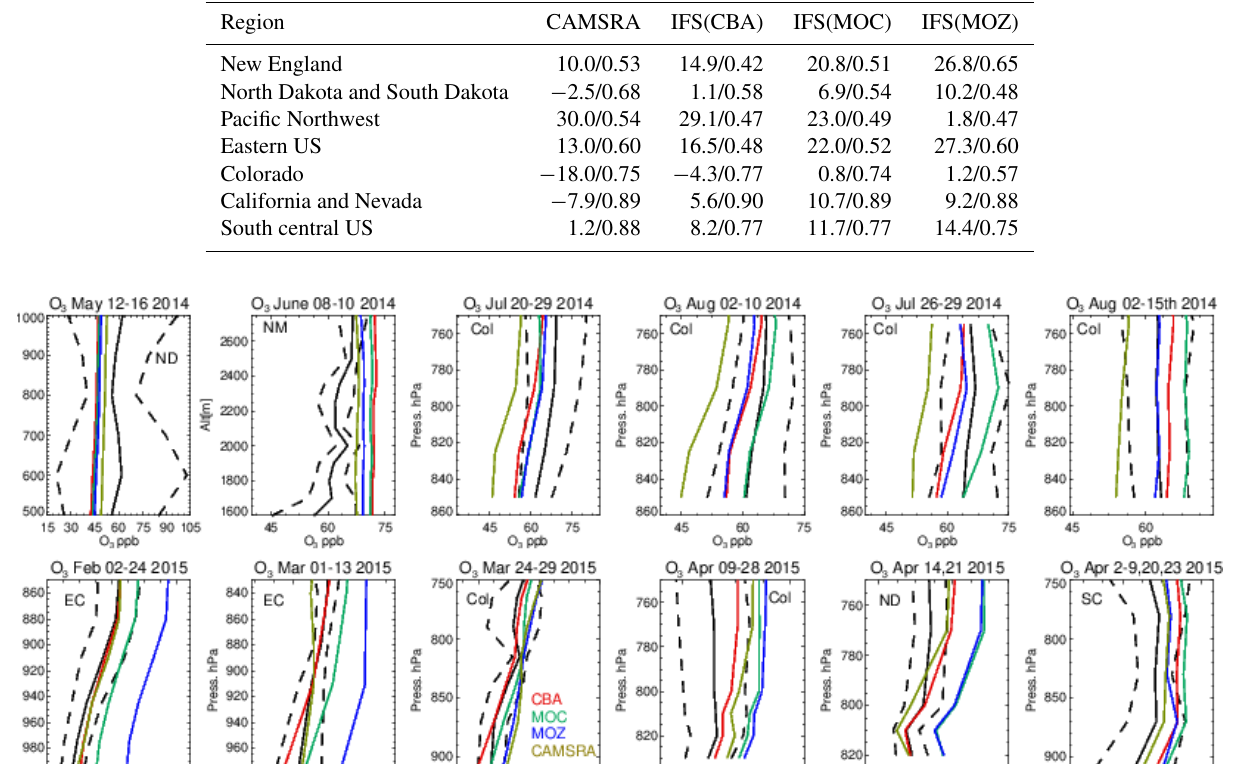
Table 7. Annual mean biases and Pearson’s R values for the comparison of surface O 3 versus AirNow data for 2014.